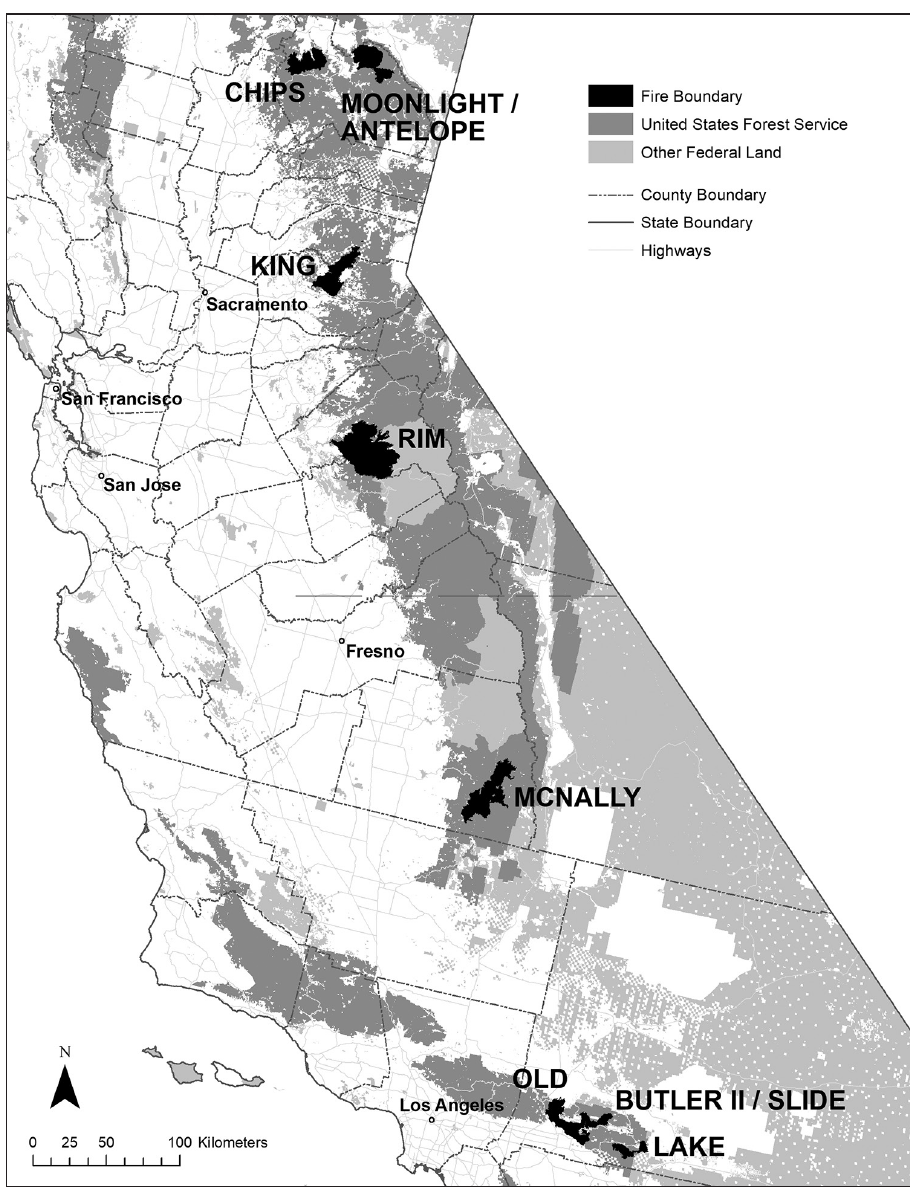
Figure 1. Large fires, in occupied California spotted owl habitat that were studied in this analysis. National Forest (prior to the Lake fire of 2015) occurred in 2011, whereas in the Rim fire of 2013, surveys were sporadic prior to the fire, but were extensive beginning in the spring of 2014, prior to post-fire logging on national forest lands. The dates of fires, pre-logging and post-logging surveys and logging are shown in Table